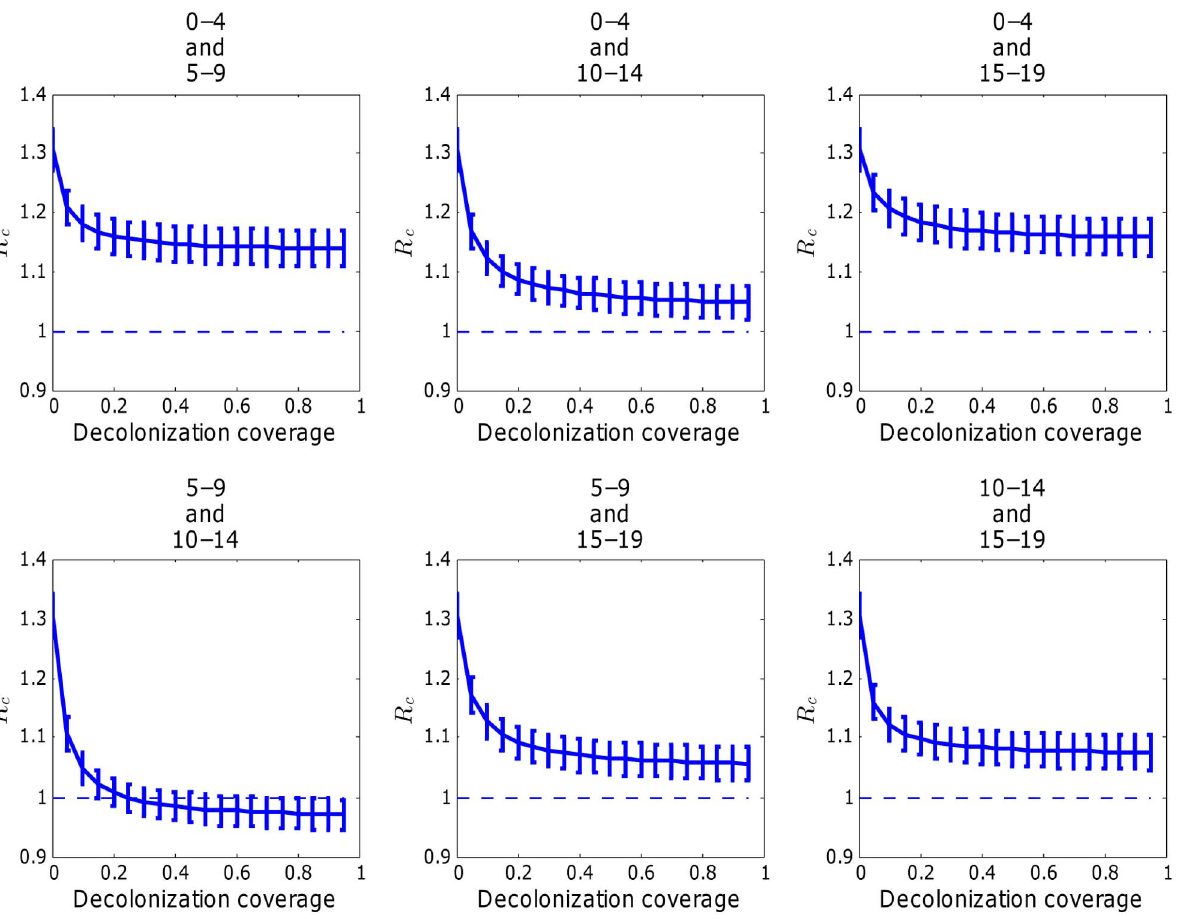
Figure 8. Mean R c with different levels of decolonization treatment coverage for colonized people in various combinations of two of pediatric groups. The error bars are based on standard deviations of R c s under parameter uncertainty.